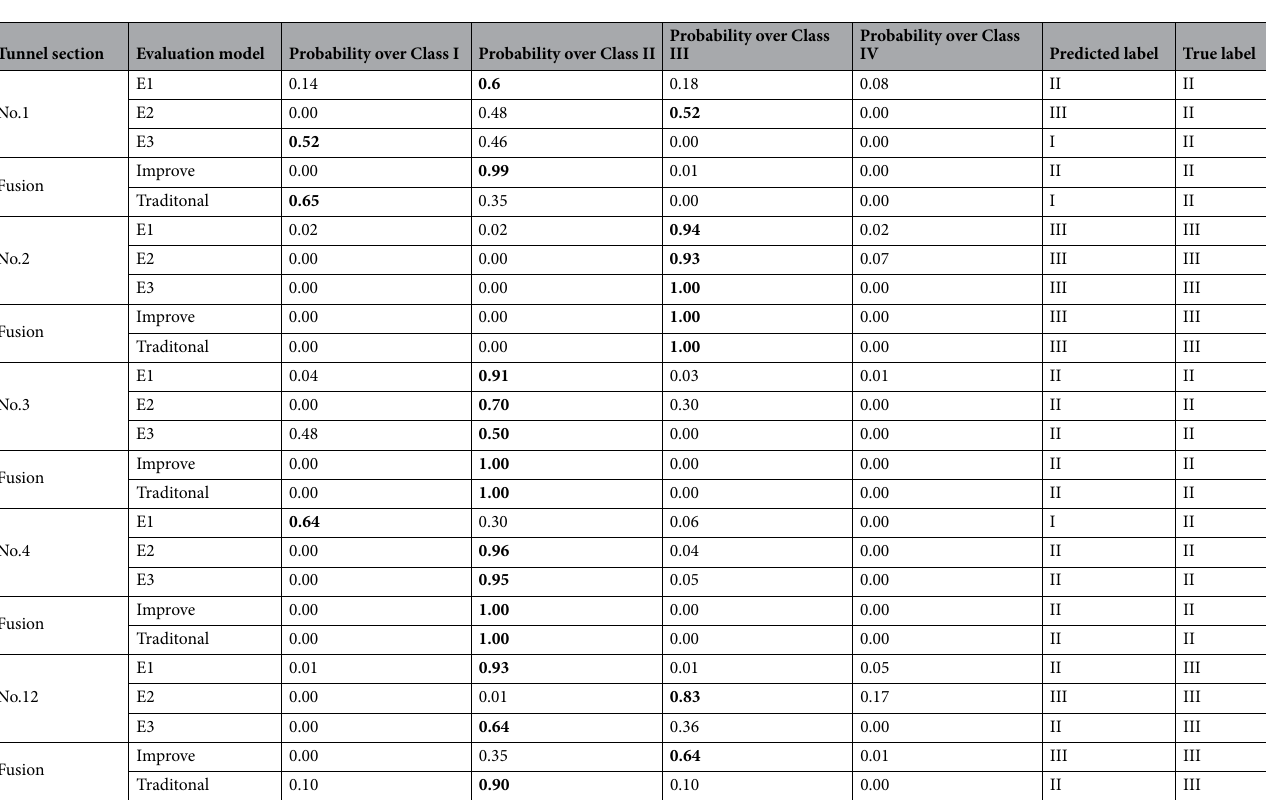
Table 9. Comparison of fusion methods. Significant values are in